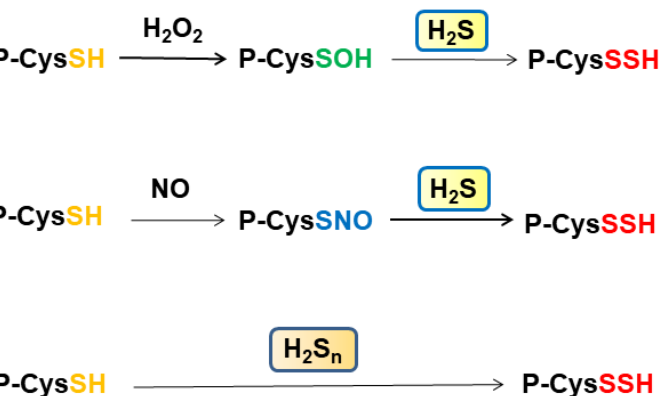
Figure 2. S -Sulfuration of cysteine residues by H 2 S and H 2 S n . Cysteine residues are S -sulfenylated by H 2 O 2 and S -nitrosylated by NO. These oxidized cysteine residues are S -sulfurated by H 2 S. In contrast, cysteine residues are S -sulfurated by H 2 S n .